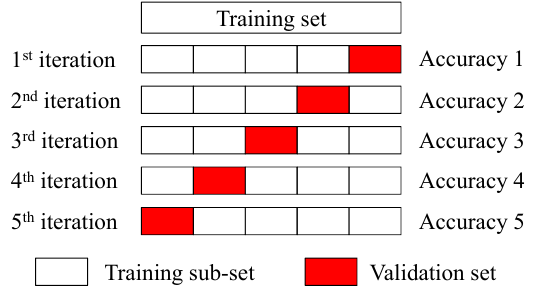
Figure 7. Flowchart of five-fold CV.